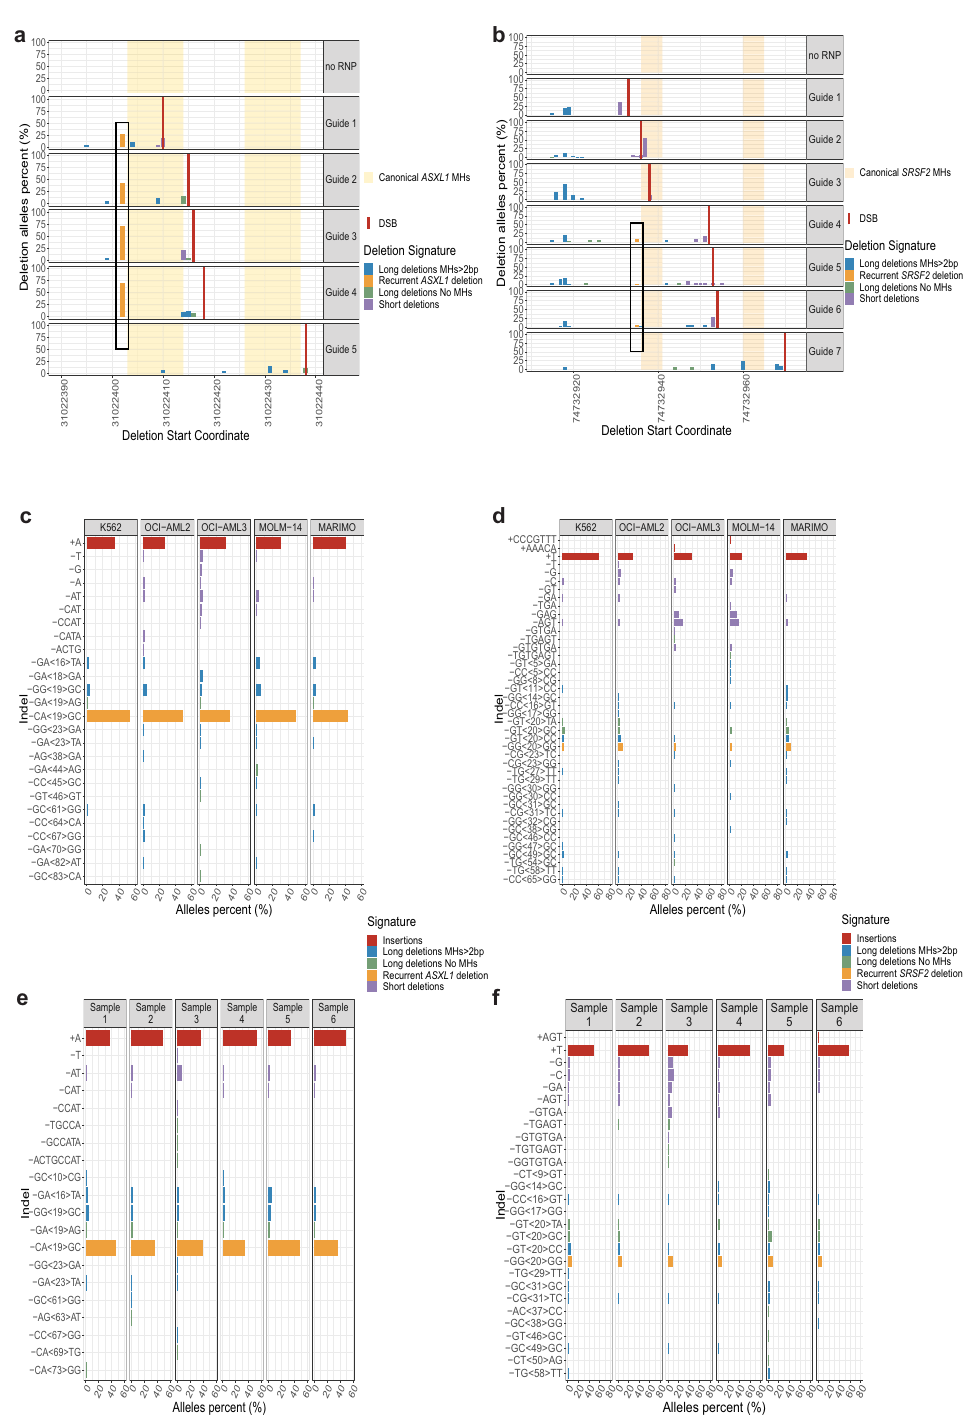
Fig. 4 CRISPR/Cas9 mediated DSBs recapitulate recurrent MH-based deletions in myeloid malignancies. a , b Start genomic positions and percentage of ASXL1 ( a ) and SRSF2 ( b ) deletion alleles among the total deletion alleles obtained for each sgRNA guide as assessed by deep targeted sequencing (read depth 5000X) in the K562 cell line. Insertions are not shown. Deletion signatures are: ≥ 5-bp deletion with fl anking microhomologies (MHs) of at least 2 bp (blue), ≥ 5-bp deletion with fl anking MHs of zero or 1 bp (green), short deletion (<5-bp) (purple) and the recurrent deletions in ASXL1 ( a ) or SRSF2 ( b ) genes (orange). Canonical MHs (orange and yellow backgrounds), sequential DSBs (vertical red lines) and the recurrent deletions (black outlines) are marked along the ASXL1 ( a ) and SRSF2 ( b ) sequences. ‘ no RNP ’ controls represent samples treated with Cas9 in the absence of sgRNAs. c – f Indel sequences and percentage of ASXL1 ( c , e ) and SRSF2 ( d , f ) modi fi ed alleles among the total indel alleles as assessed by deep targeted sequencing (read depth 5000X) in K562, OCI-AML2, OCI-AML3, MOLM-14 and MARIMO cells ( c , d ) or primary human CD34 + hematopoietic stem and progenitor cells isolated from six individuals ( e , f ) following the induction of DSBs in ASXL1 ( c , e ) and SRSF2 ( d , f ) loci. Allele percent of 0.5% ( c , e ) or 1% ( d , f ) and above are shown. Deletion signatures are as described in a, b with the addition of insertions (red). Source data are provided as a Source Data fi